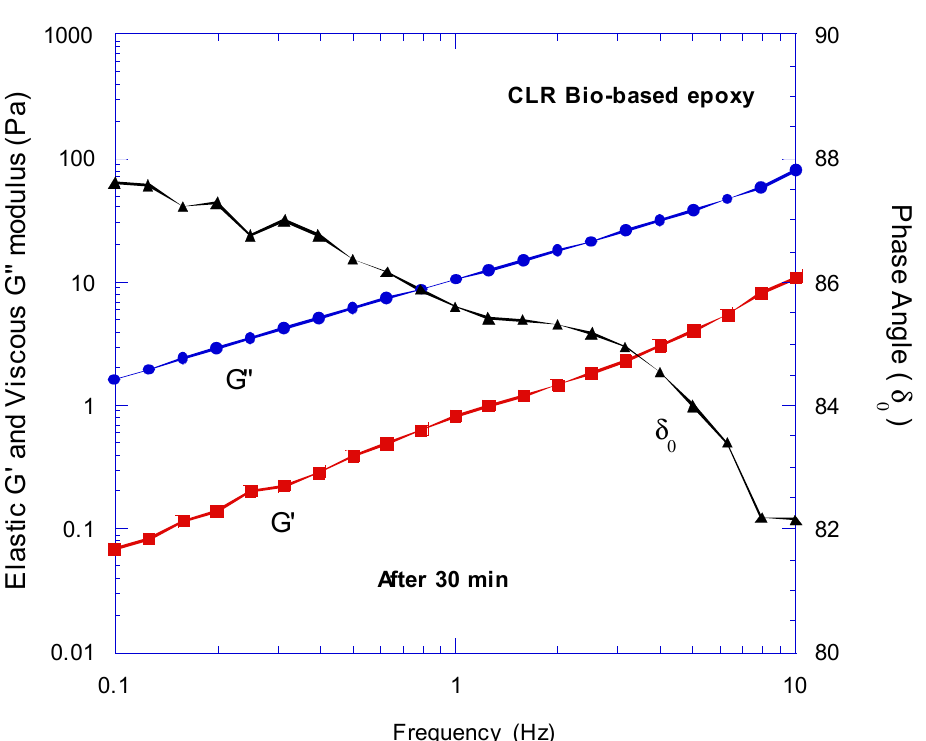
Figure 7. Frequency sweep result of CLR epoxy 30 min after the mixing of the hardener.